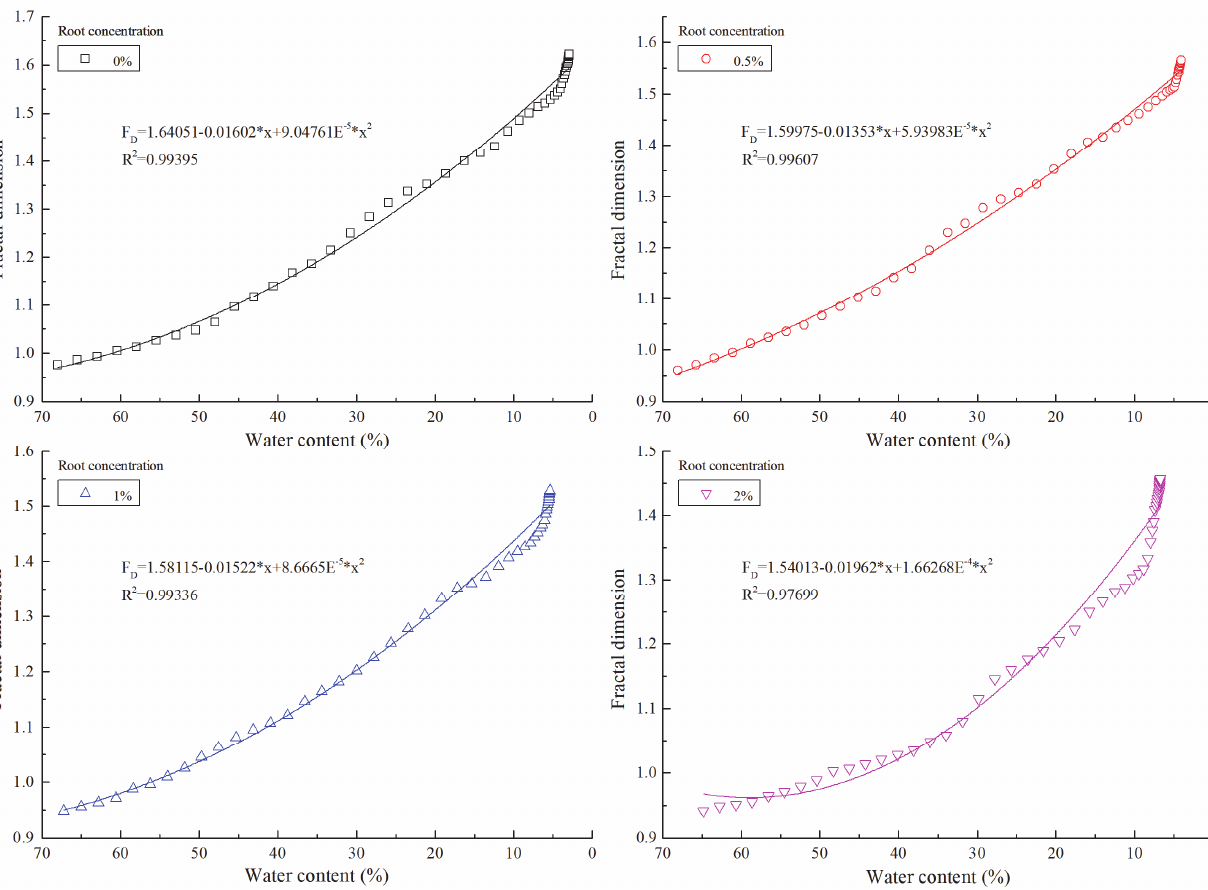
Figure 7. Relationship between water content and fractal dimension.